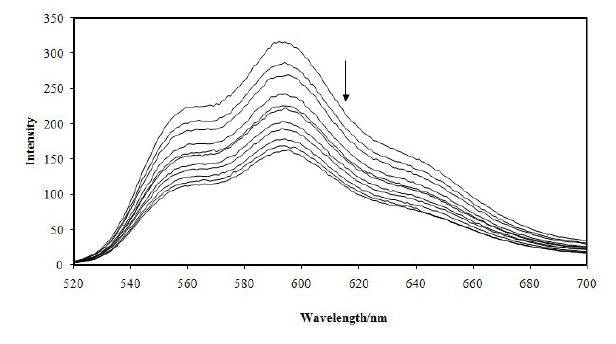
Figure 7. Fluorescence spectra of the EPR in different concentrations of ds-DNA. ＝ 0.0, 10.0, 20.0, 30.0, 40.0, 50.0, 60.0, 70.0, 80.0, 90.0 and 100.0 μmol L -1 for curves C DNA ＝ 50.0 μmol L -1 in phosphate buffer (0.1 mol L -1 , pH 7.4) at excitation 1-11, and C EPR wavelength of 482 nm.